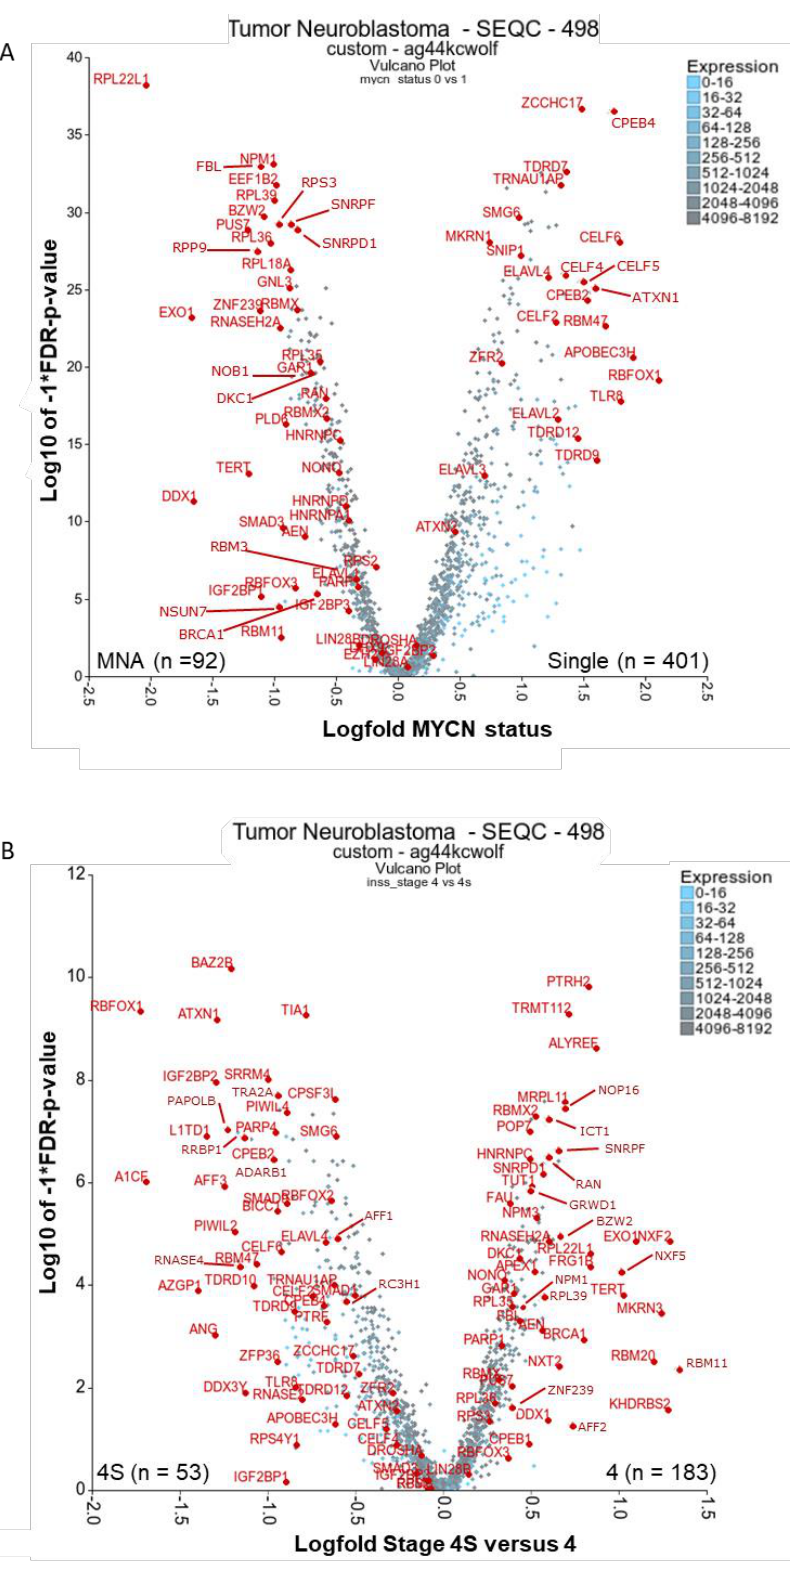
Figure 1. Di ff erential expression of RNA-binding proteins (RBPs) in clinically relevant neuroblastoma groupings. The RBP gene list from Gerstberger, et al. 2014 [17] was used to filter for RBP mRNAs and then compare ( A ) MYCN status of tumours or ( B ) Stages 4 and 4S. Both the analyses were displayed as a volcano plot using the two groups plotter option of the visualisation tool R2 (https: //